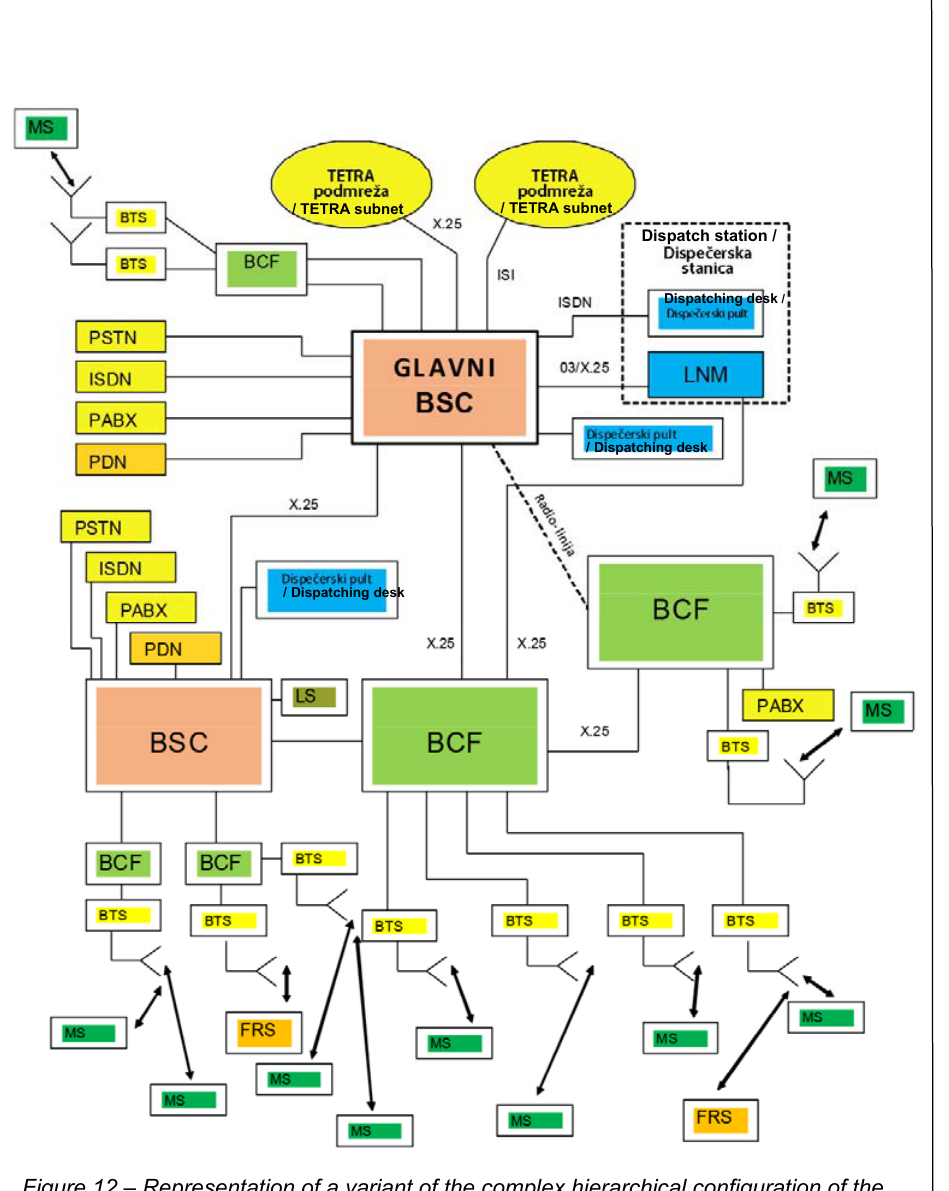
Figure 12 – Representation of a variant of the complex hierarchical configuration of the TETRA 1 subnet (Ovchinnikov et al, 2000) Рис . 12 – Представление варианта сложной иерархической конфигурации подсети TETRA 1 (Ovchinnikov et al, 2000) Слика 12 – Приказ варијанте сложене хијерархијске конфигурације